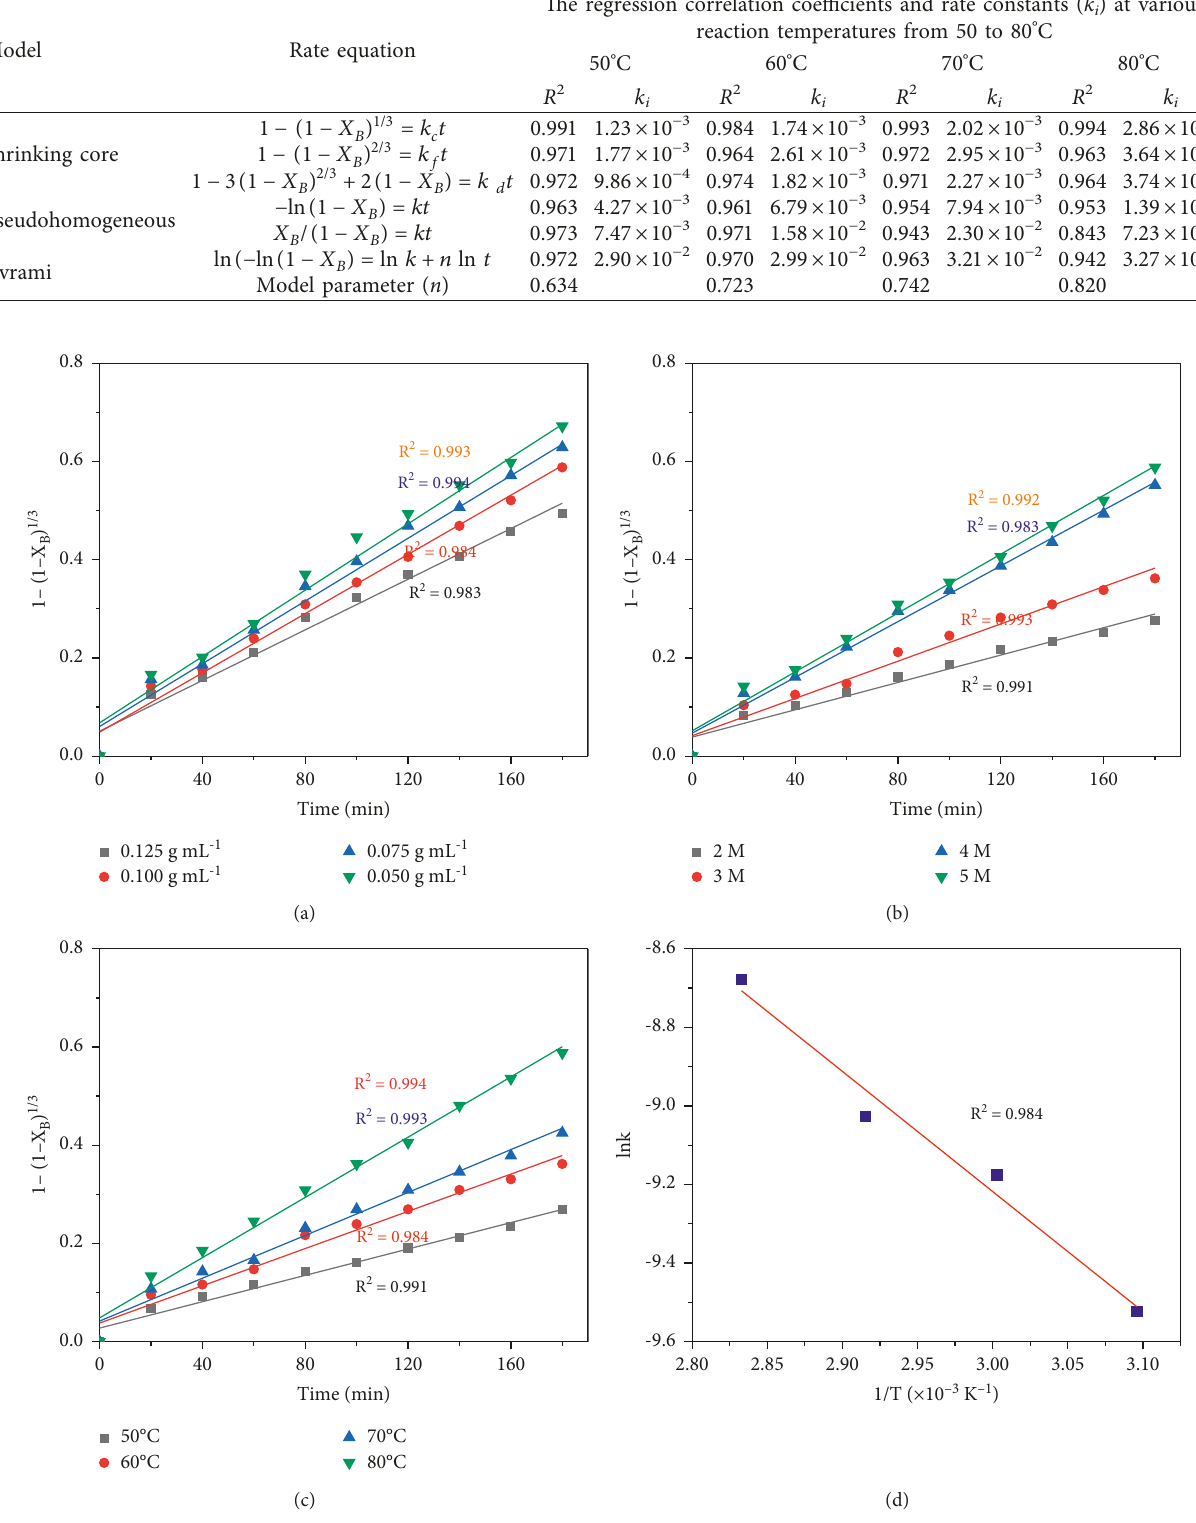
Table 3: The regression correlation coefficients and rate constants for extraction of aluminum at various reaction temperatures from 50 to 80 ° C.